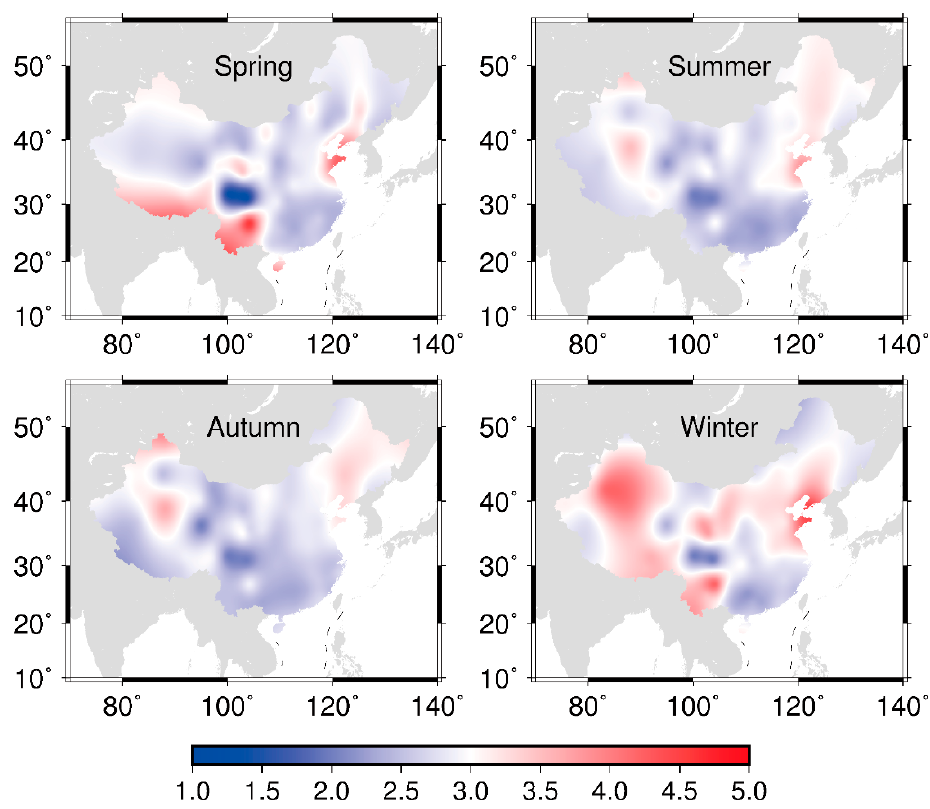
Figure 3. The values of the coefficient ω in different seasons derived from the radiosonde profiles based on the Gauss distance-weighting function.